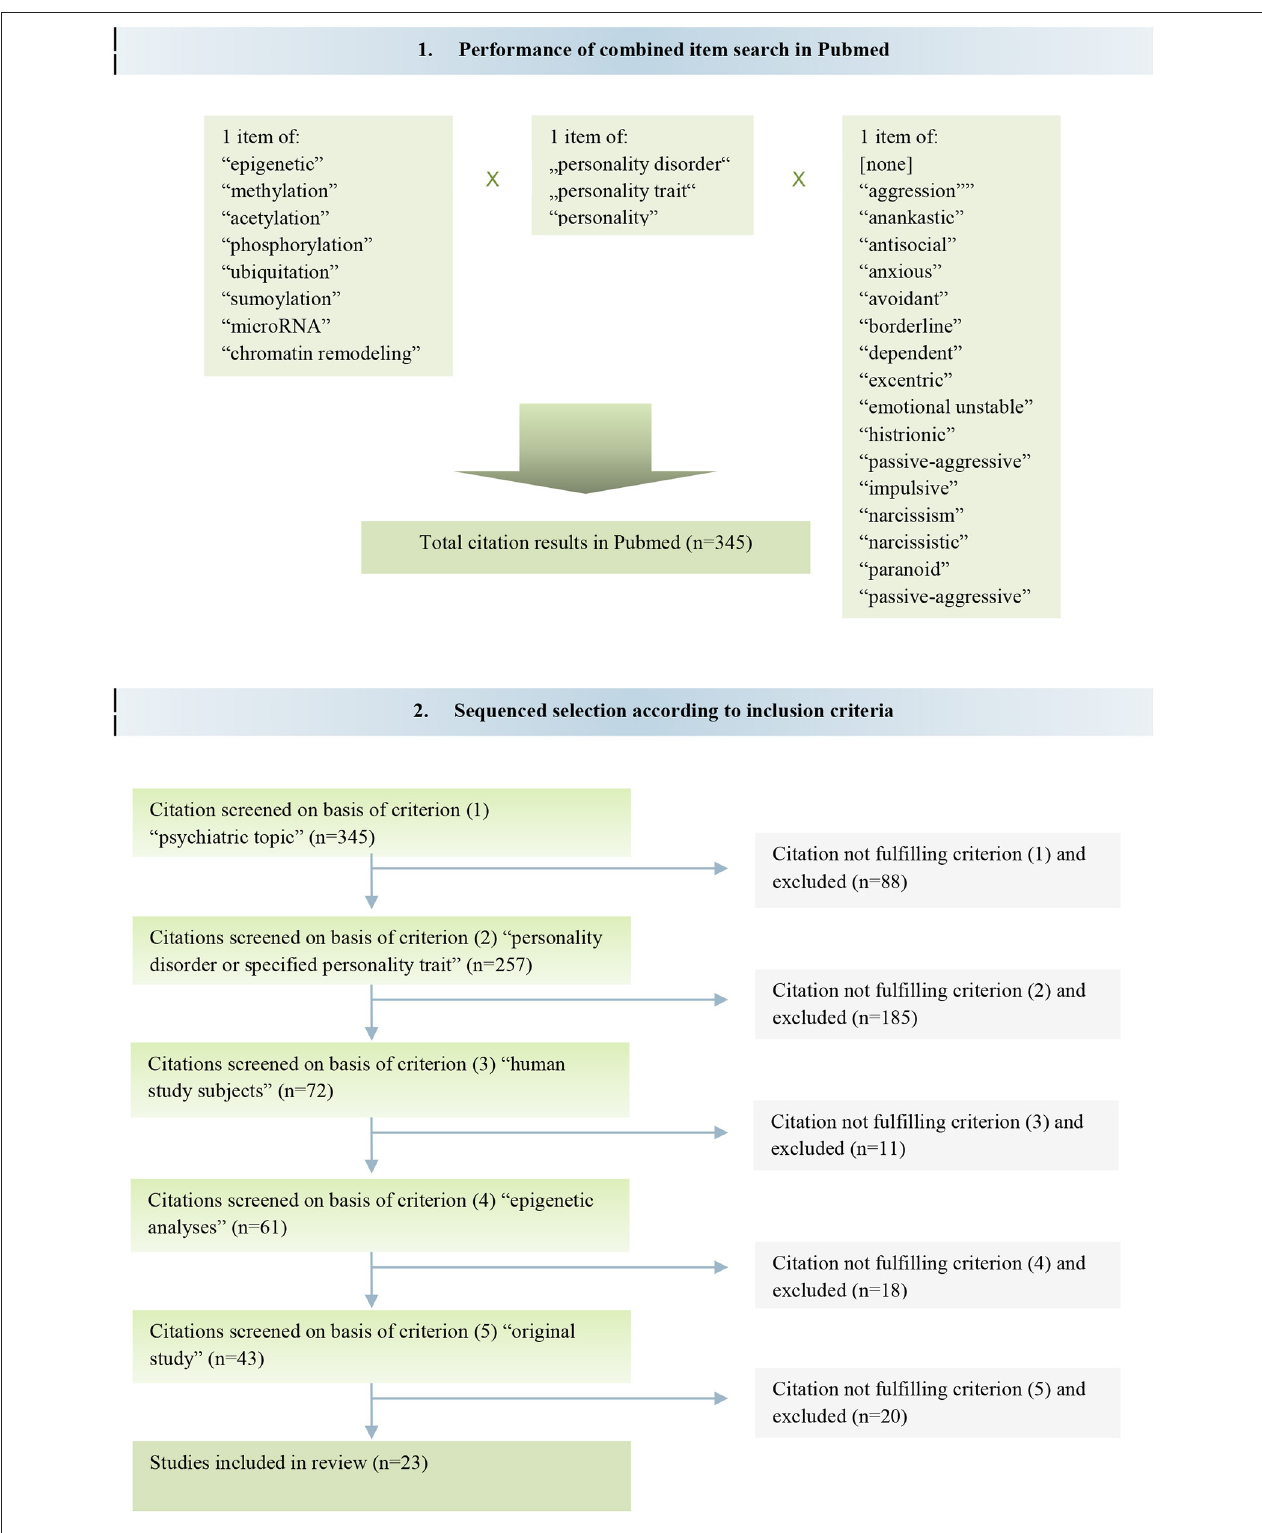
FIGURE 1 | Flow diagram of study search and sequenced